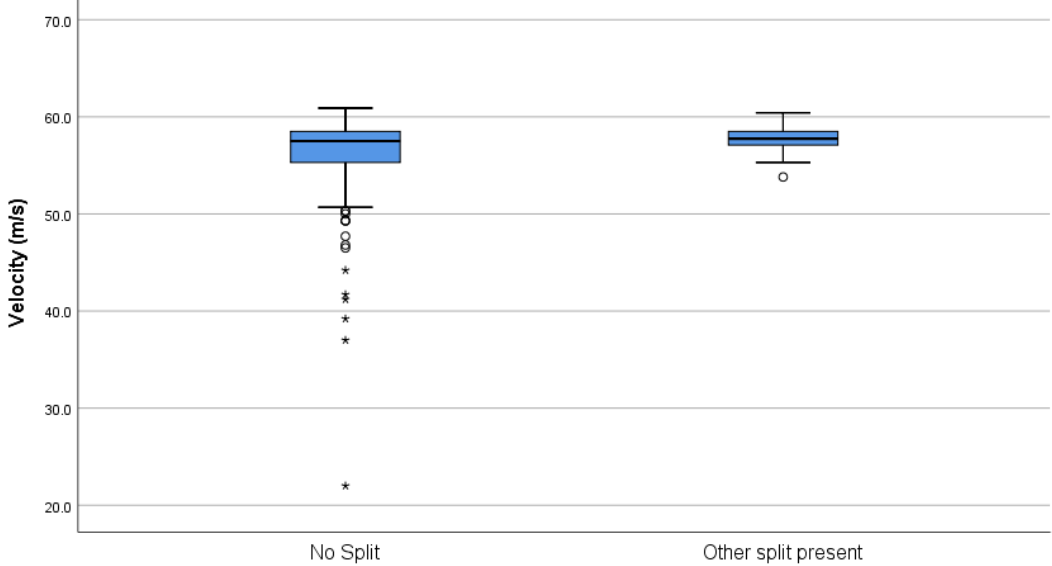
Figure 9. Plot of velocities recorded at 11.4 mm extension for AS cartridges where, post firing, a longitudinal split n = 40 (labelled “other split” to di ff erentiate from primer flange split) was found in the case or no split was encountered. The dots indicate outliers (quartiles ± 1.5 × the interquartile range), and the asterisks, extreme outliers (quartiles ± 3 × the interquartile range).